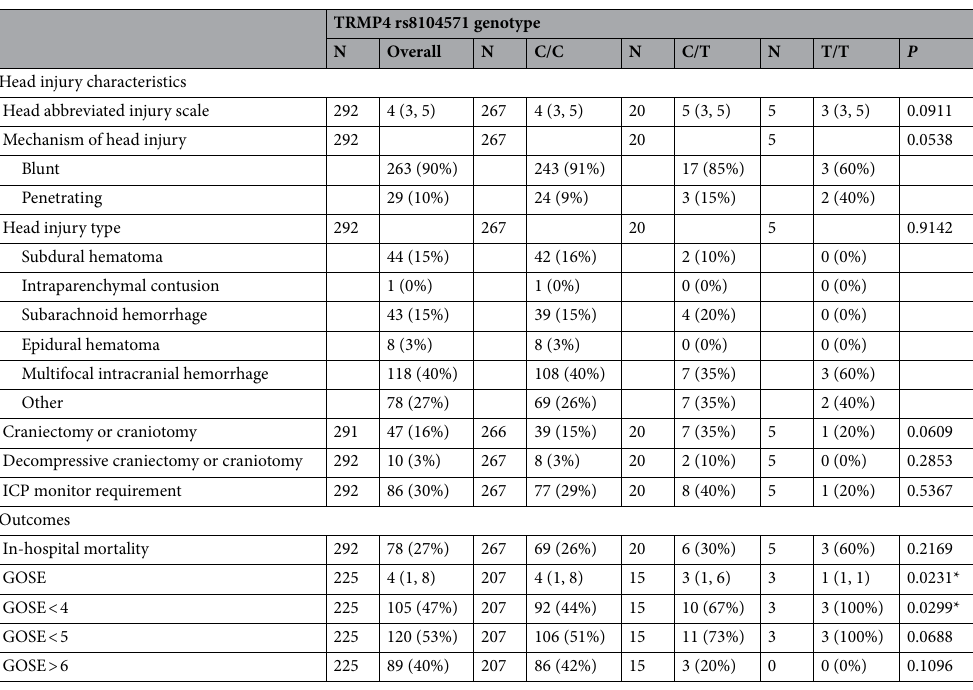
Table 3. Head injury characteristics, clinical outcomes, and TRMP4 rs8104571 genotype distribution for the overall study population denoted as median (IQR) or number of observations (%). C cytosine, T thymine, ICP Intracranial pressure, GOSE Glasgow outcome scale-extended, recorded on first follow-up visit, ICU intensive care unit; *Significant P values < 0.05.